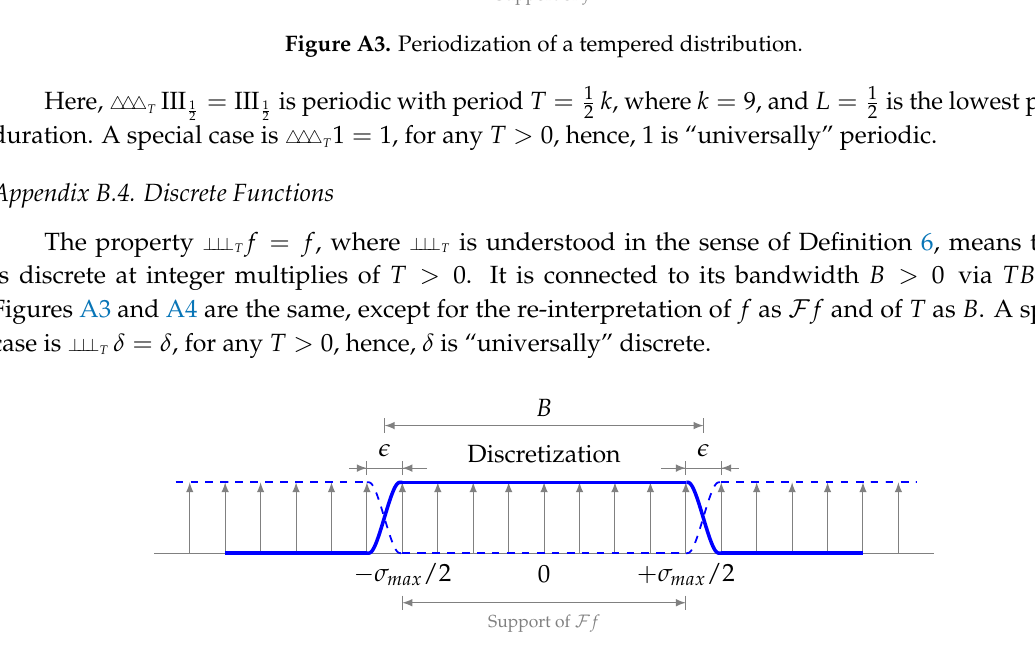
Figure A4. Discretization of a tempered distribution via periodization of its Fourier transform.